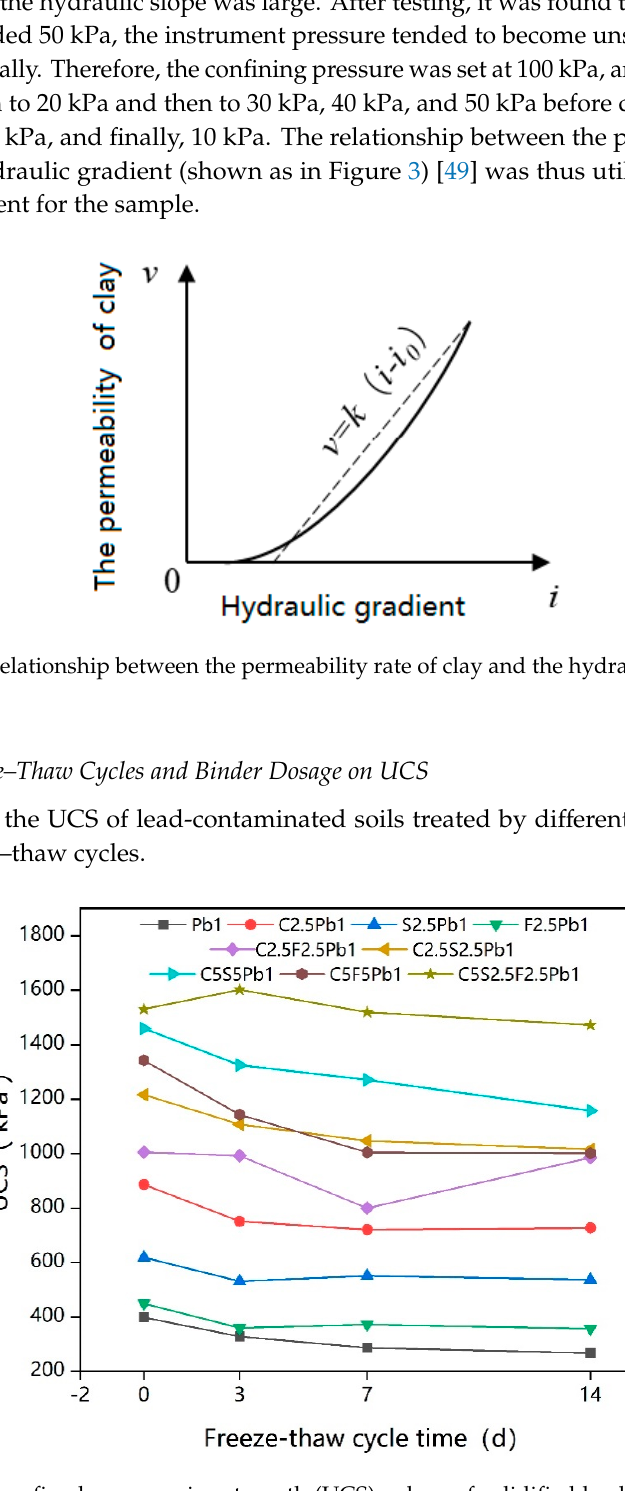
Figure 4. The unconfined compressive strength (UCS) values of solidified lead-contaminated soils under short-term freeze–thaw cycles. Table 6. Hydrolysis hydration of cement.